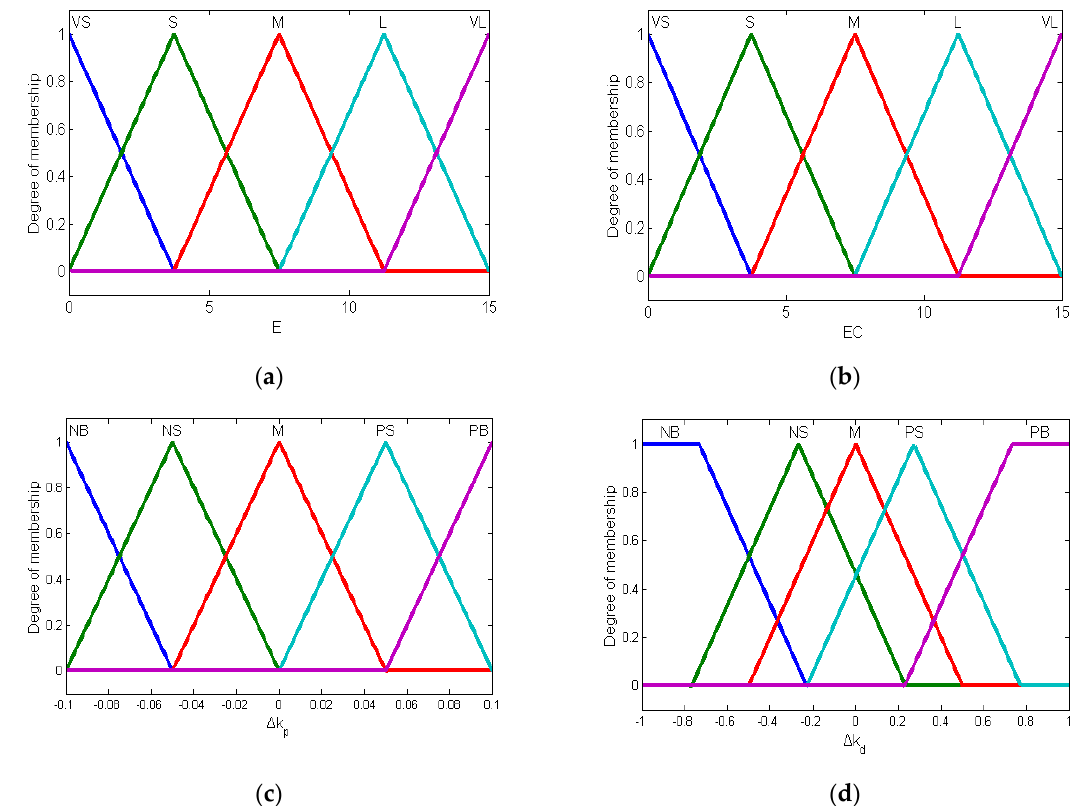
Figure 9. Fuzzy membership function design for input/output parameter of the fuzzy controller. ( a ) membership of E ( k ), ( b ) membership of EC ( k ), ( c ) membership of Δ k p , ( d ) membership of Δ k d .